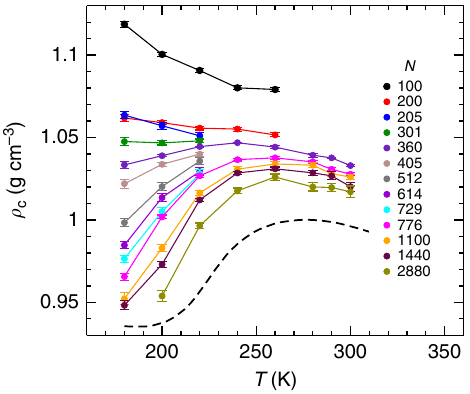
Fig. 5 Density maximum of liquid nanodroplets. Plot of ρ c versus T for water nanodroplets of fi xed N (symbols). The dashed line is the P = 0 isobar of ρ for bulk TIP4P/2005 water taken from ref. 21 , which corresponds to the expected behaviour of ρ c for droplets as N → ∞ . Error bars represent one standard deviation of the mean.